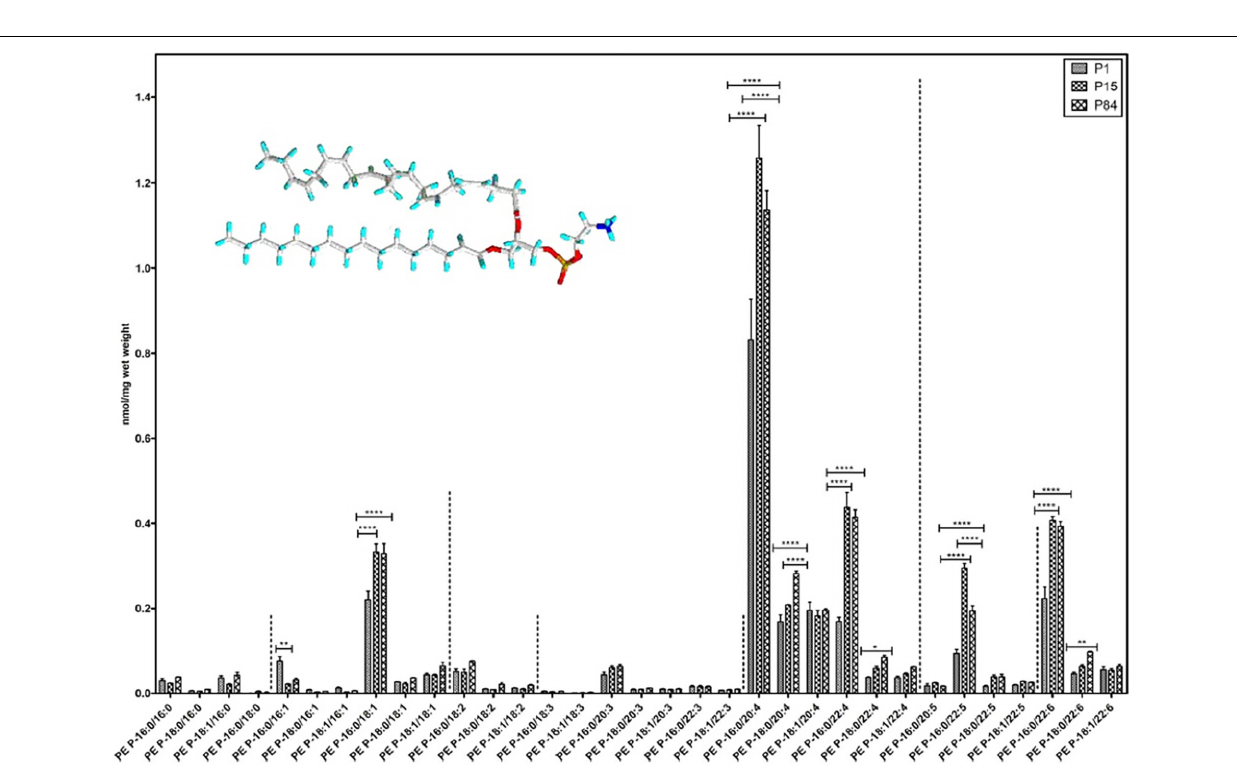
Frontiers in Cell and Developmental Biology |